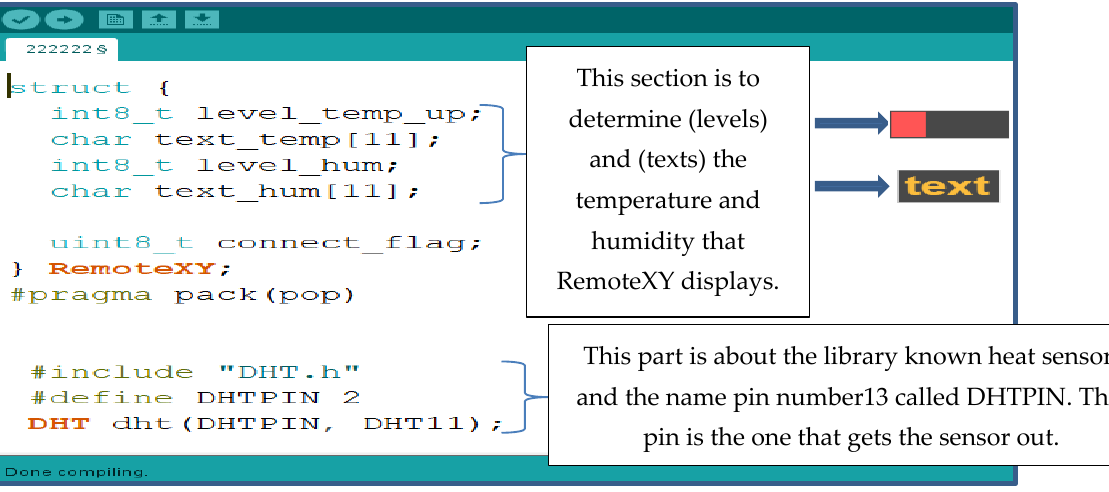
Figure A4. The second part of the executed code used to control the fan speed.